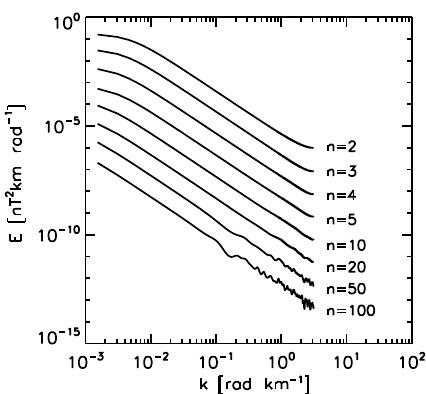
Figure 2. Minimum variance spectra for different numbers of spa- tial samplings for a spectral slope of − 2. The spectra are shifted from one to another for the visualization